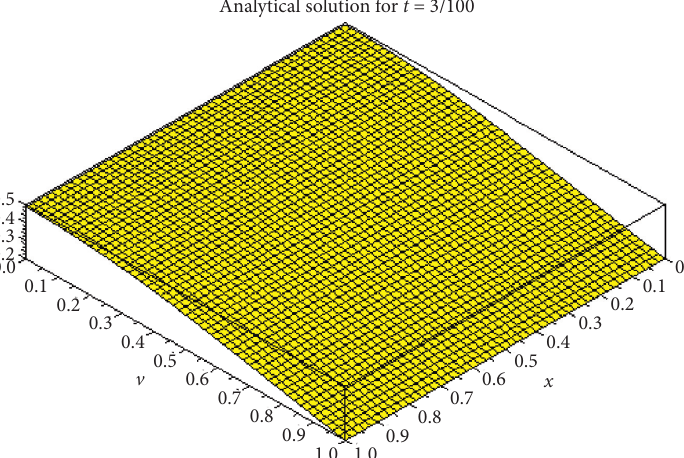
( x,v ) for h � 1/50. 1